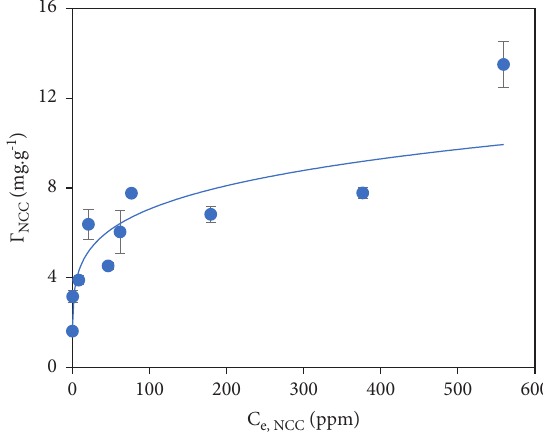
Figure 10: NCC adsorption on the PVBTAC-modified α -Al particles was well fitted with Freundlich model at conditions: C i ,NCC from 10 to 600ppm, pH 8, NaCl 10mM, t of 45min, and m α - Al 2 O 3 of 3mg mL − 1